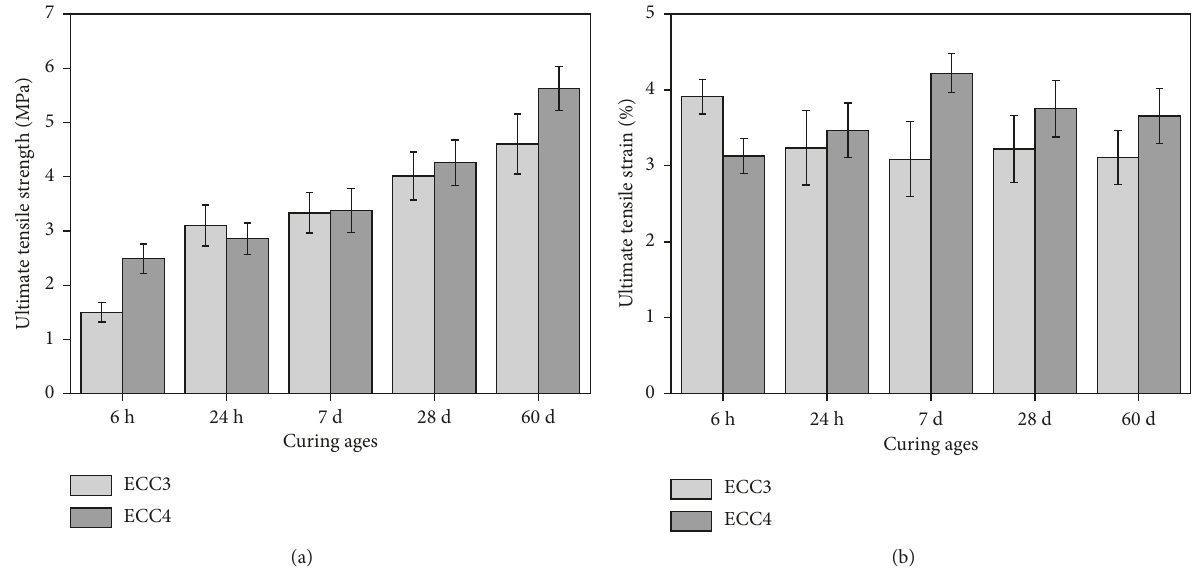
Figure 16: Comparison of tensile properties of PE HES-ECCs at different ages: (a) ultimate tensile strength; (b) tensile strain capacity.